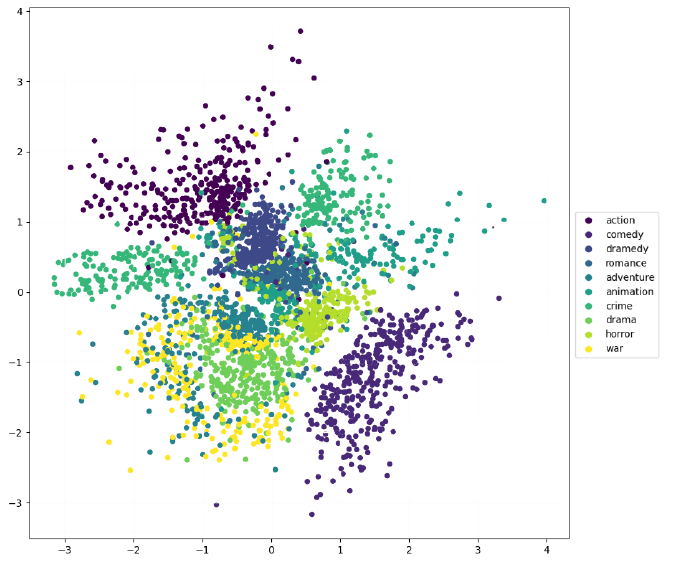
Figure 3. Second and third components of the PCA on Gaussian mixture model for latent factor distribution for CF